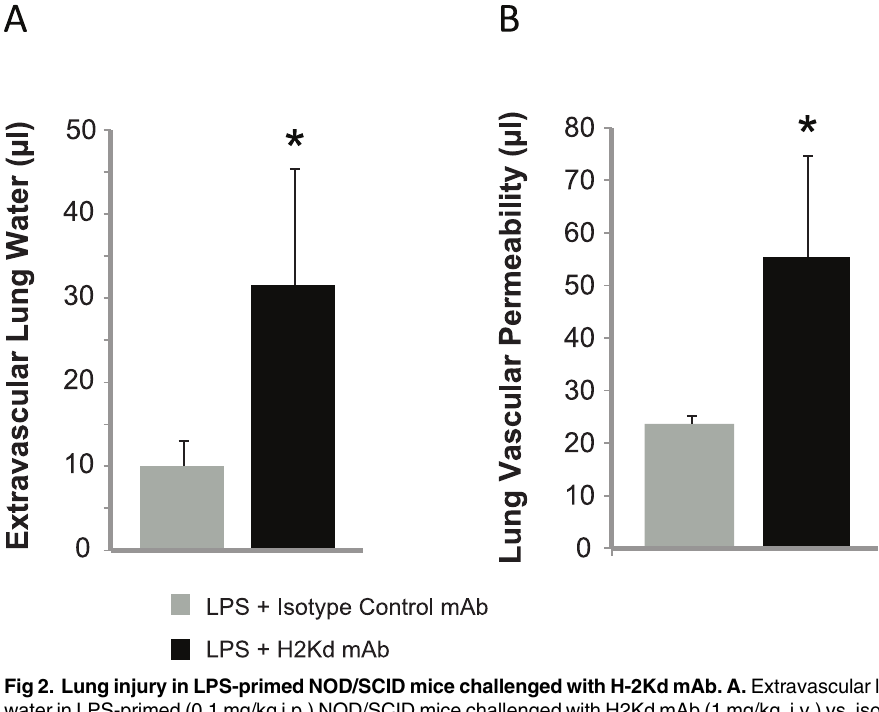
Fig 2. Lung injury in LPS-primed NOD/SCID mice challenged with H-2Kd mAb. A. Extravascular lung water in LPS-primed (0.1 mg/kg i.p.) NOD/SCID mice challenged with H2Kd mAb (1 mg/kg, i.v.) vs. isotype control mAb. B. Lung vascular permeability to 125 I-albumin (i.v.) in LPS-primed (0.1 mg/kg i.p.) NOD/SCID mice challenged with H2Kd mAb (1 mg/kg, i.v.) vs. isotype control mAb. * p < 0.05 vs. LPS + isotype control mAb groups. Mean ± SD. n = 5 per